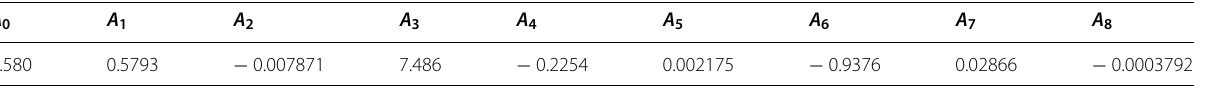
Table 3 Resultant coefficients of the risk curve for specific ages, fitted to Eq. 14 A